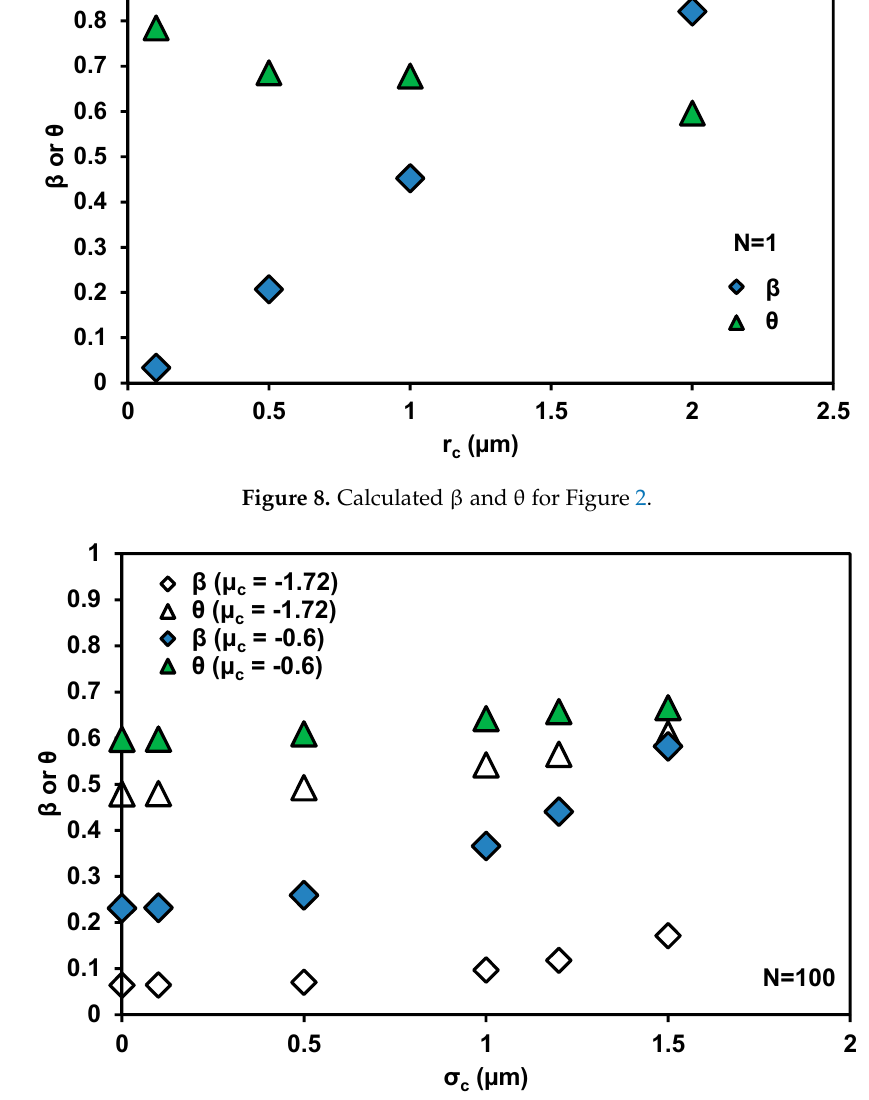
Figure 9. Calculated β and θ for Figures 5a and 7a.